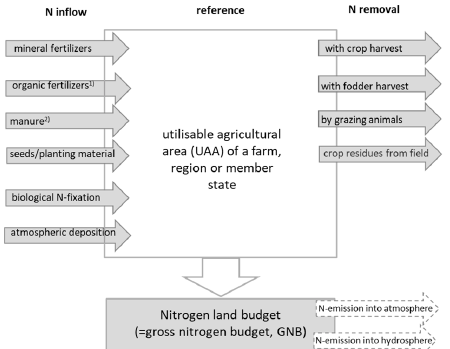
Figure 2. The gross nitrogen budget (GNB) [3]: (1) according to the current methodology, no reductions are made for nitrogen losses due to volatilization in stables, storages and with application to the land; (2) “manure”: total manure production by livestock (calculated by N excretion) minus manure withdrawals, plus manure import, plus change in manure stocks. Source : own design, according to